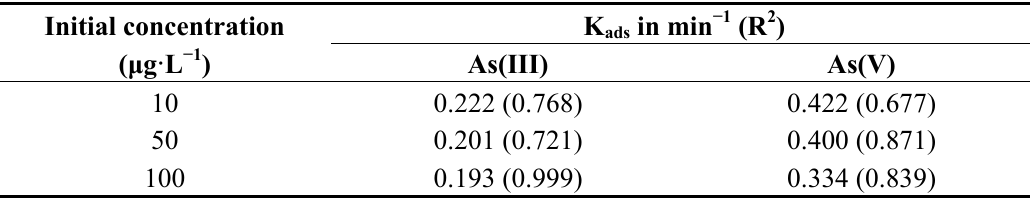
Table 2. Adsorption rate constants of magnetite nanoparticle at different initial